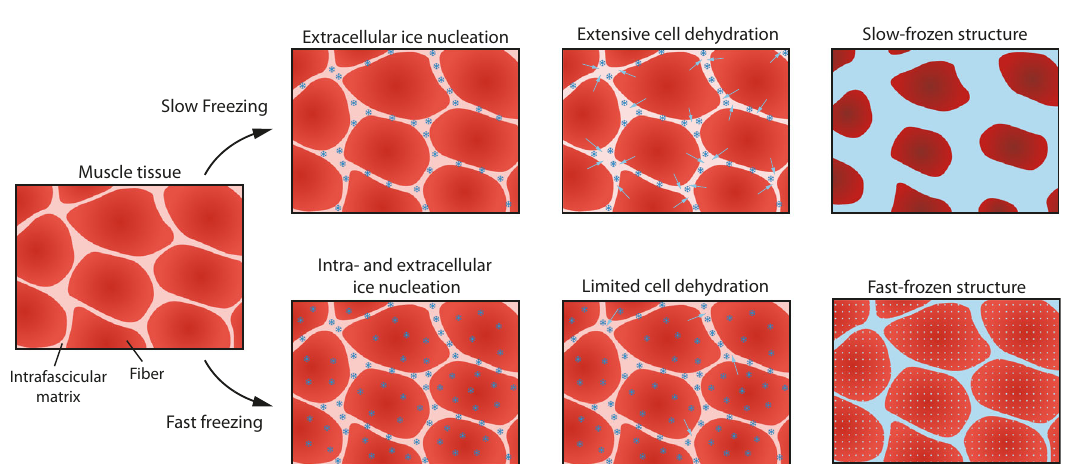
Fig. 5 | 3D histopathology of pressure overload-induced hypertrophic murine heartsfollowingTACsurgery. Bargraphsshowingthemass( a )andvolume( b )of the murine hearts of the sham and TAC group. Longitudinal sections of the same heartthroughtheleftandrightventricle,obtainedbyconventionalCECT( c ),cryo- CECT ( d ) and classical 2D histological sectioning followed by picrosirius red staining ( e ). RA right atrium, RV right ventricle, LA left atrium, LV leftventricle, HV heartvalve.3Dspatialgraphofthecardiacmuscle fi berorientationofashamheart ( f ) and a TAC heart ( g ).Fiber orientation is represented by the inclination, or polar angle θ and is indicated by the color scale. h Average histogram of the cardiac muscle fi ber inclination comparing the sham and the TAC group. i Average histo- gram ofthe cardiacmuscle fi ber diagram (left) and a bargraph ofthe median fi ber